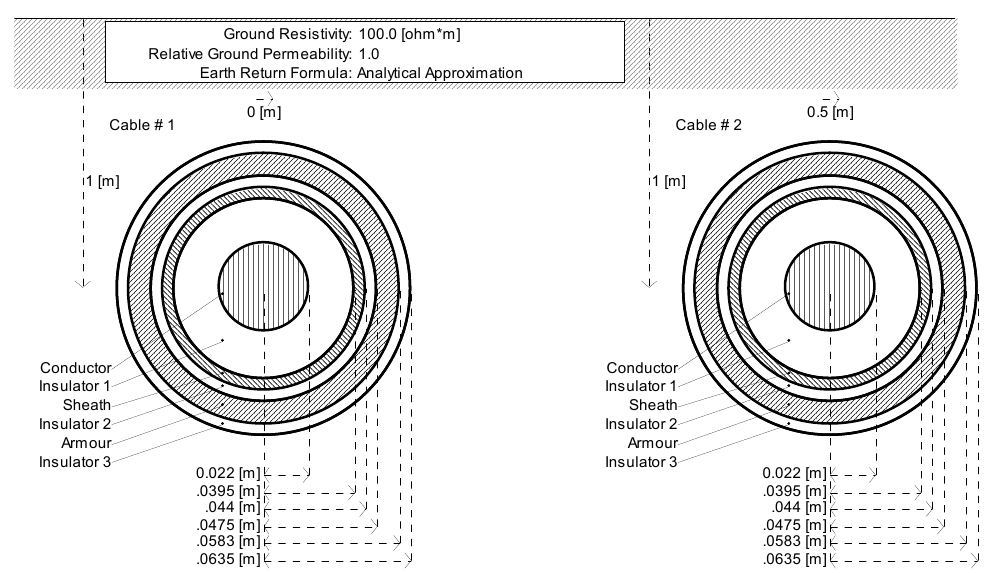
Figure 8. Fault simulation model.